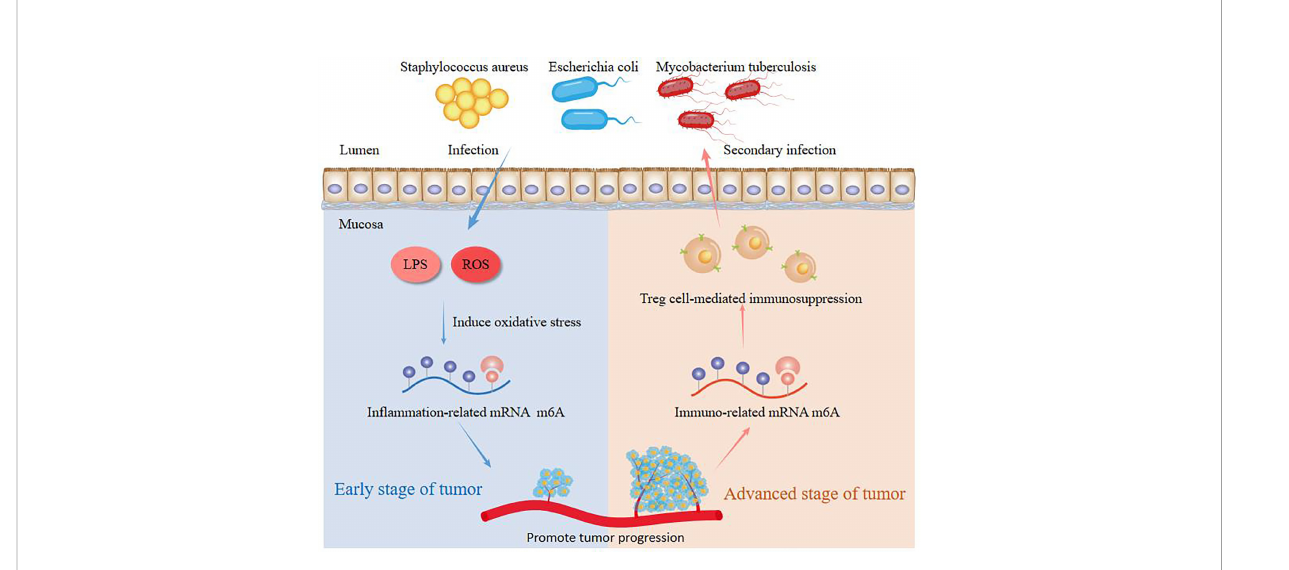
FIGURE 3 The molecular mechanisms of m6A in the interaction of host and microbes in